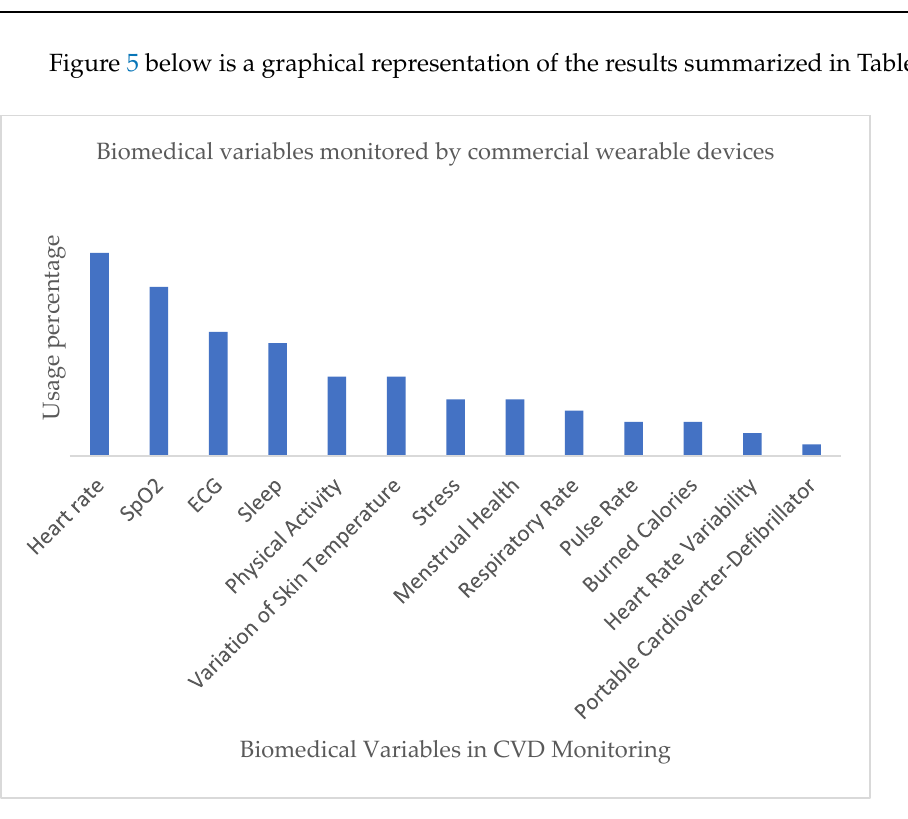
Figure 5. Classification of commercial wearables for CVD monitoring with respect to biomedical variables.